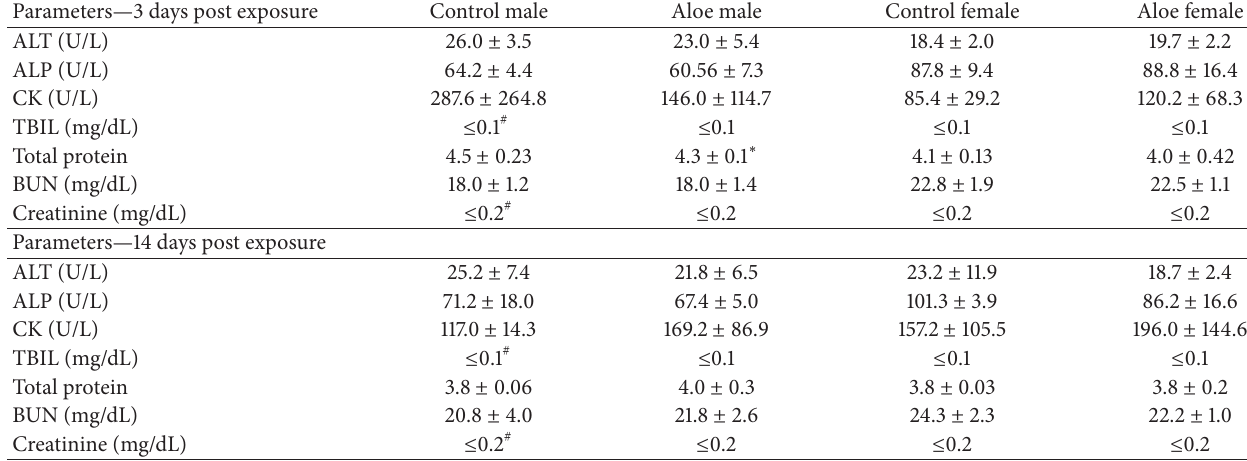
Table 4: Clinical chemistry of plasma from B6C3F1 mice administered aloe juice by gavage.